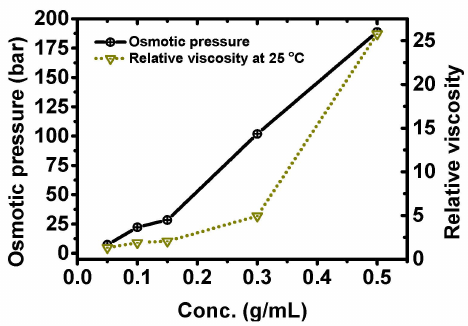
Figure 4. The osmotic pressure and relative viscosity of the STPH solution against de-ionized water (DI water) as a function of the concentration (pH =